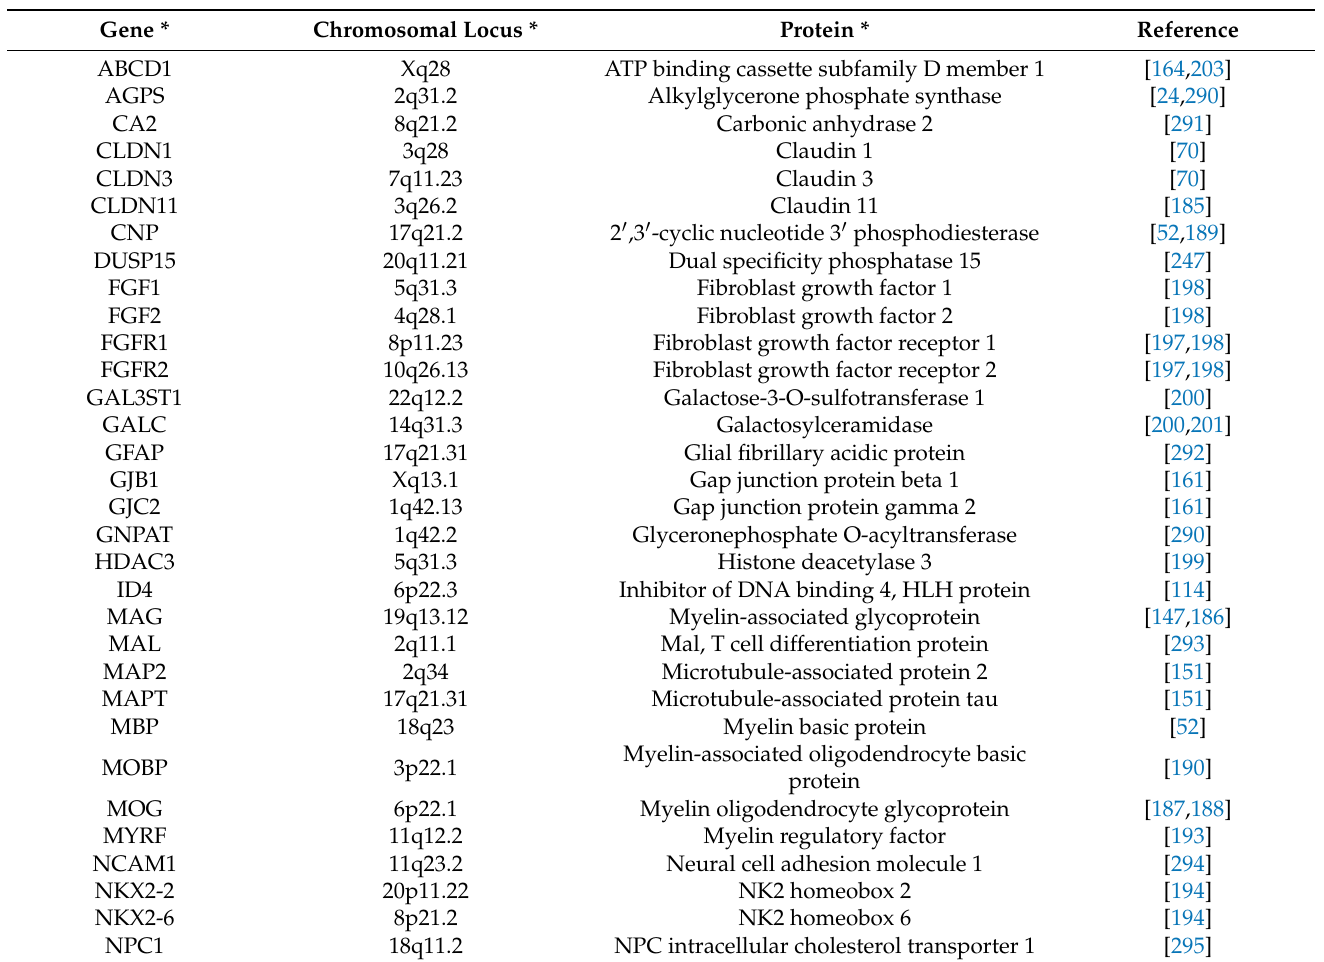
Table A3. Molecules implicated in myelin growth and